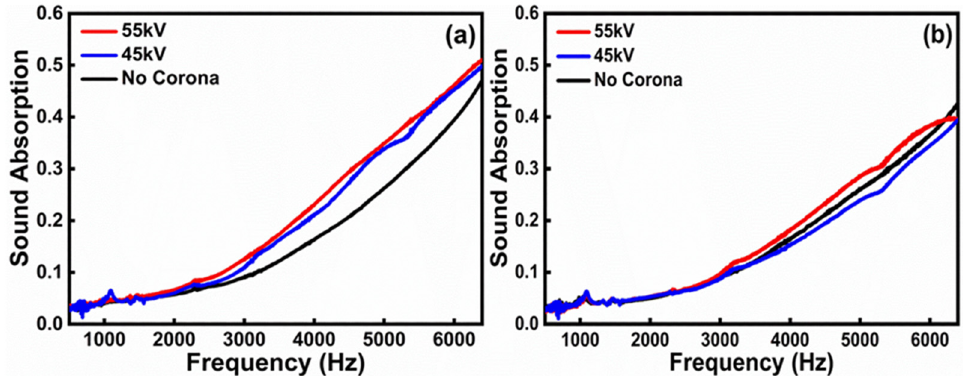
Figure 1. Sound absorption coefficient for PE foams with thicknesses of only 3 mm in the frequency range of 500–6400 Hz, ( a ) before and after corona poling at different voltages, and ( b ) after subsequent annealing treatment. Note the small but well-distinguishable change is due to the thickness constraint of only 3 mm, in contrast to standard sample thickness of 25 mm. The small thickness was selected to realize effective corona poling effect for the mechanism study. To realize a significant level of sound absorption for most practical applications, multilayers of small-thickness foams can be used.